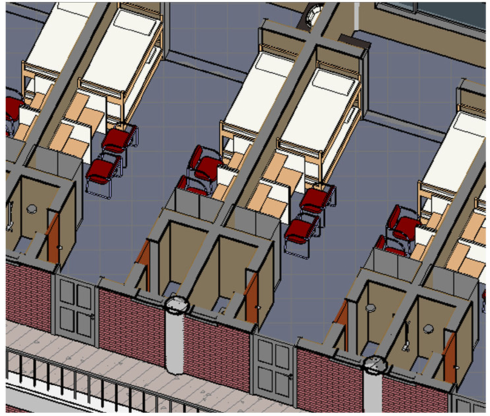
Figure 2. Dormitory interior in the BIM model.